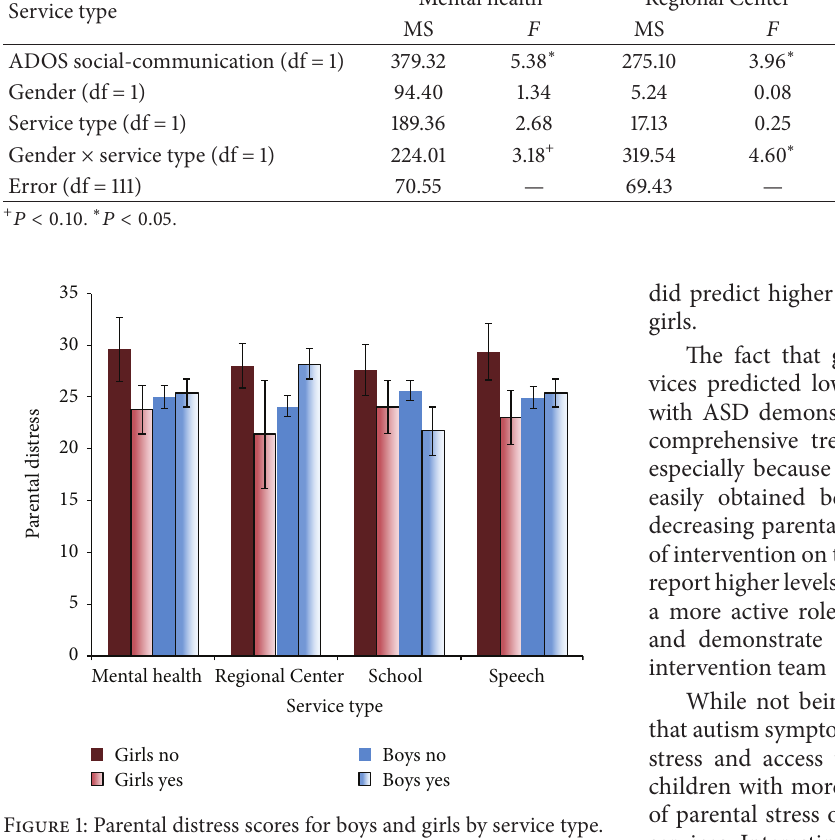
Figure 1: Parental distress scores for boys and girls by service type. Note: error bars indicate standard error of the mean. 𝑁 = 27 girls, 89